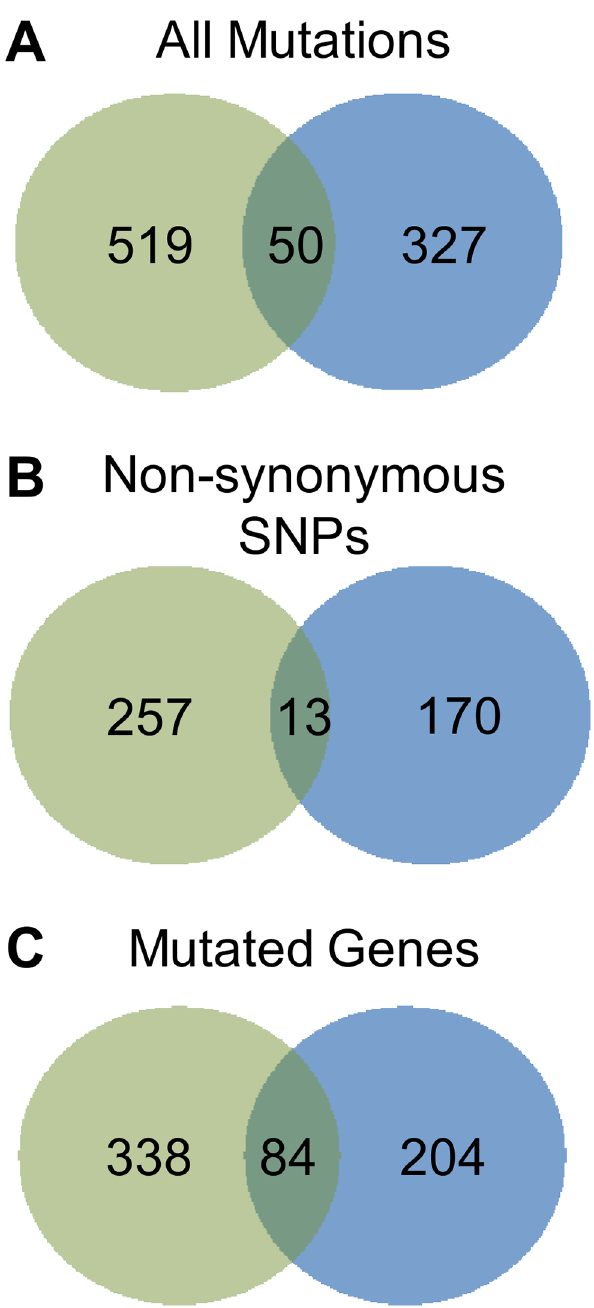
Fig 3. Parallel evolution of endpoint populations was observed from Trials 1 and 2. Venn diagrams represent the number of (A) all mutations, (B) nsSNPs, or (C) genes that were observed in the individual trials (Trial 1, green; Trial 2,